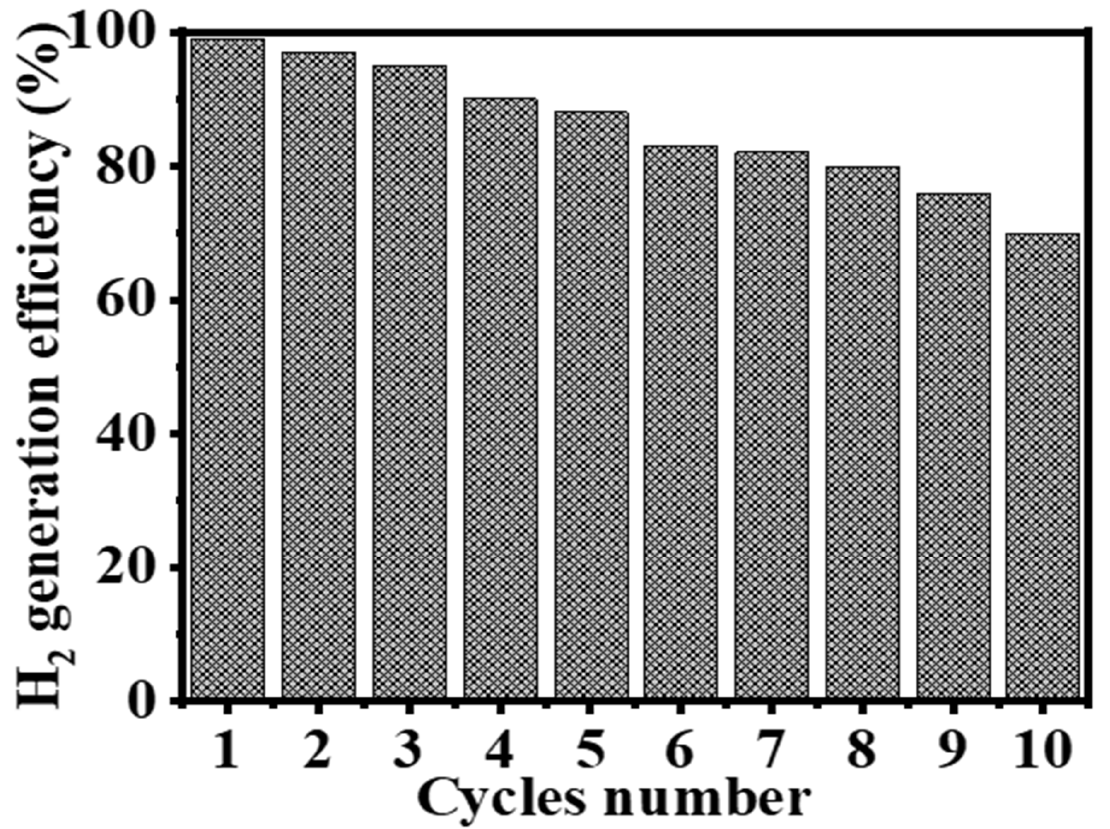
Figure 10. Reusability test of the Ni 0.3 Co 0.7 @ PVDF-co-HFP NF membrane. [Quantity of catalyst = 100 mg, [SBH] = 1 mmol, and T = 298 K].